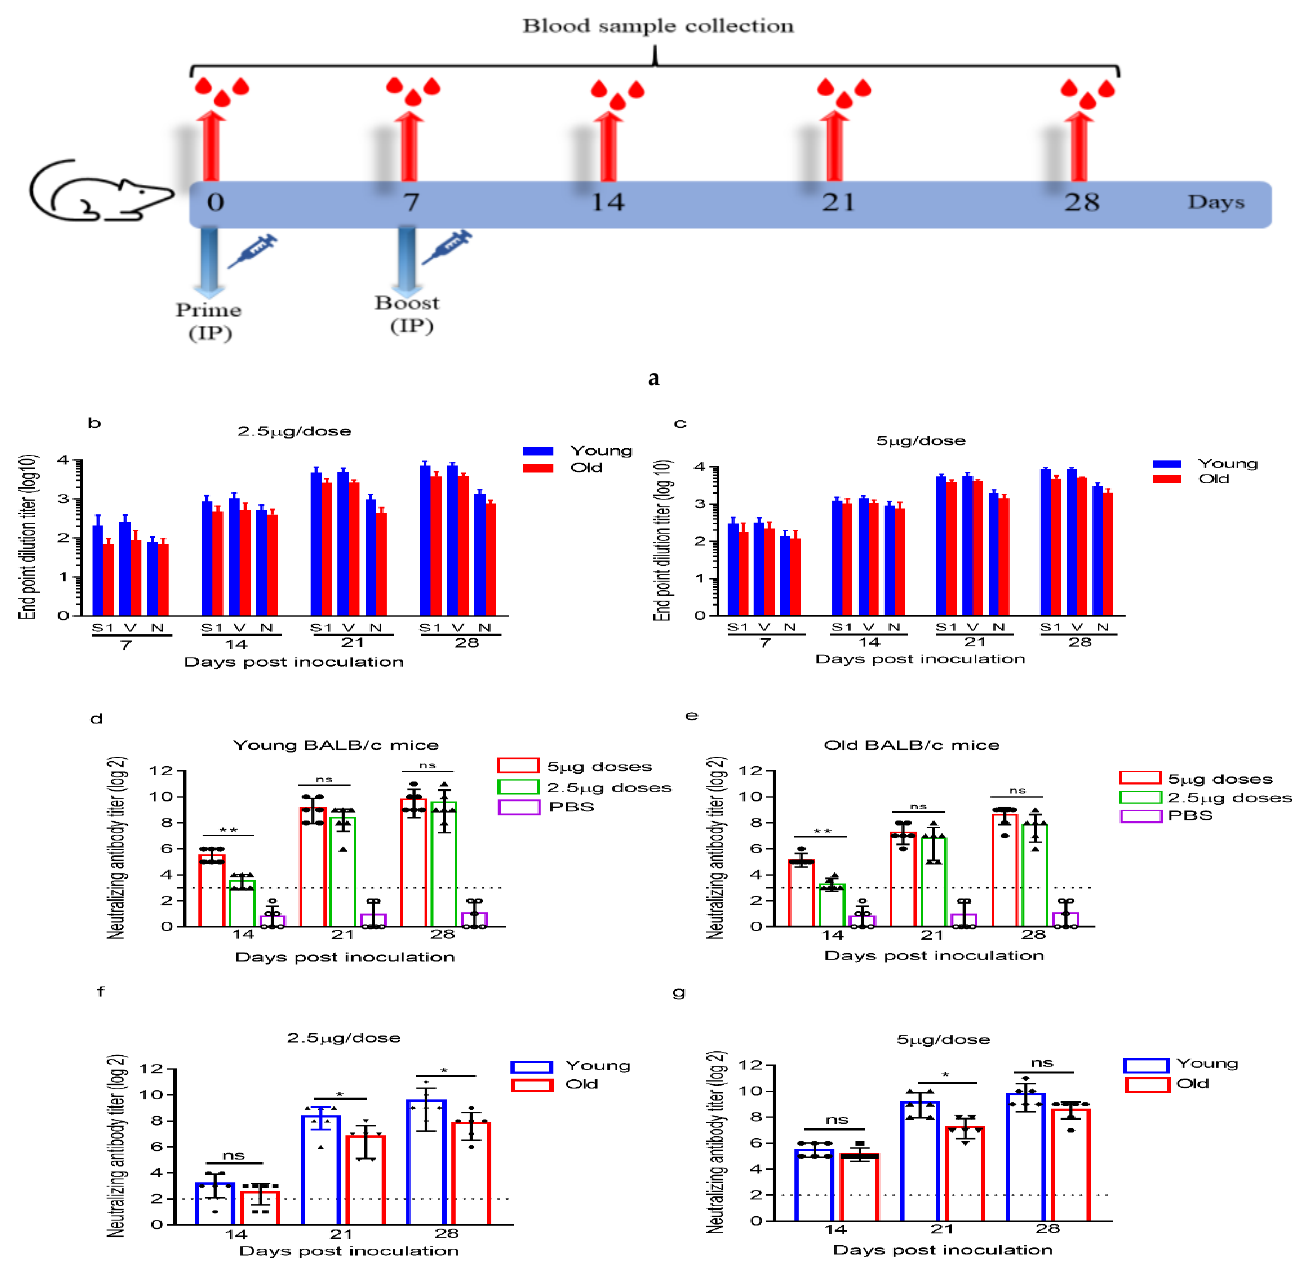
Figure 2. ERUCoV-VAC immunogenicity in old and young BALB/c mice. ( a ) Schematic diagram of sample collection and immunization regimens. Serum IgG titres were detected by SARS CoV-2-specific S1-RBD (S1), virion (V), and nucleocapsid (N) ELISA in young ( n = 6) and old BALB/c ( n = 6) mice vaccinated with 2.5 µg ( b ) and 5 µg ( c ) doses of ERUCoV-VAC. Serum Nab titres determined by microneutralizing assay in young ( d ) and old mice ( e ) vaccinated with 2.5 µg and 5 µg doses of ERUCoV-VAC. Comparison of serum Nab titres in young and old BALB/c mice vaccinated with 2.5 µg ( f ) and 5 µg ( g ) doses of ERUCoV-VAC. The statistical significance was assessed using a two-way ANOVA test and a Mann–Whitney test between groups; p values less than 0.01 were considered to be statistically significant where ** denotes 0.01; and * denotes 0.05; ns: not significant. Error bars represent mean ± standard deviation. The dotted line illustrates the highest value measured in the normal control group.